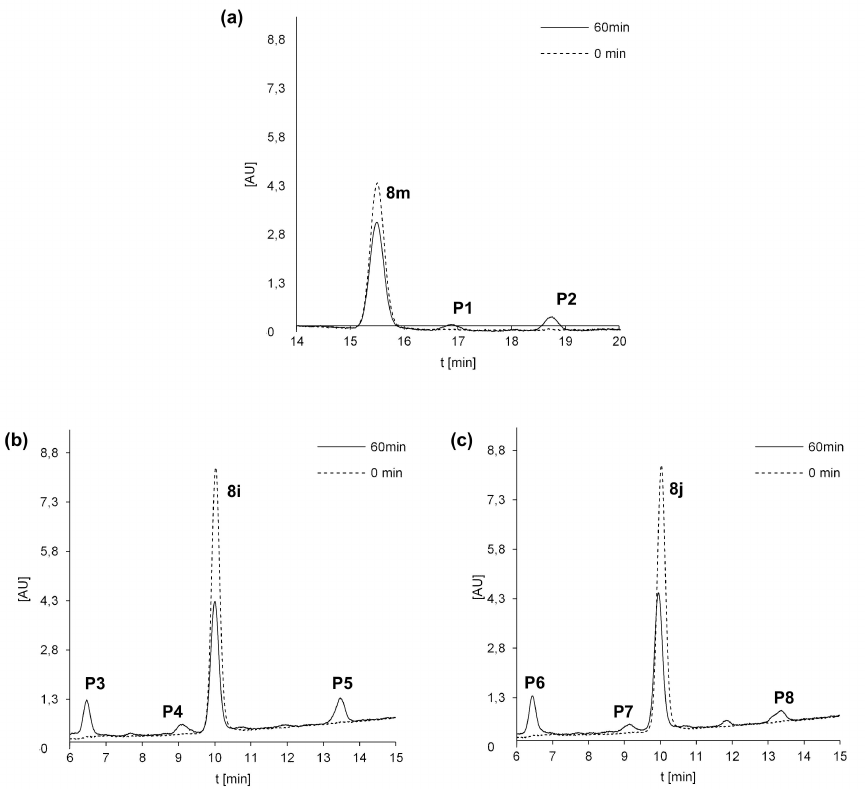
Figure 4. Metabolism of 8m ( a ), 8i ( b ) and 8j ( c ) with rat liver microsomes (RLMs) and NADPH as cofactors. Representative HPLC chromatograms of the incubations of 0.05 mM 8m , 8i and 8j at 37 ◦ C with 2 mg/mL of RLM in the presence of 2 mM NADPH.